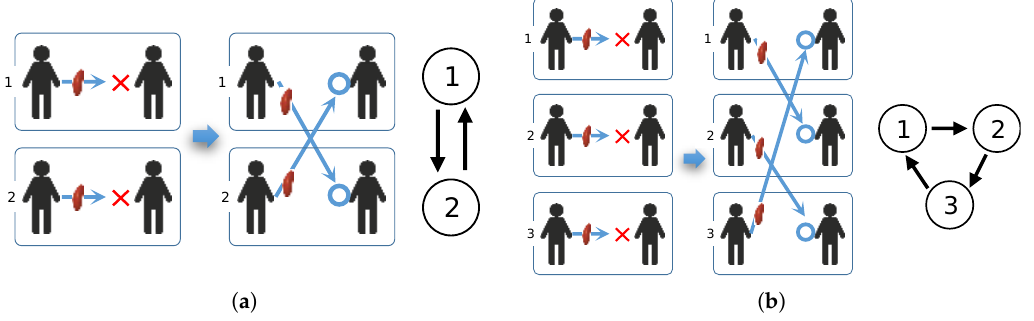
Figure 1. Illustration of ( a ) two-way and ( b ) three-way kidney exchange program (KEP).